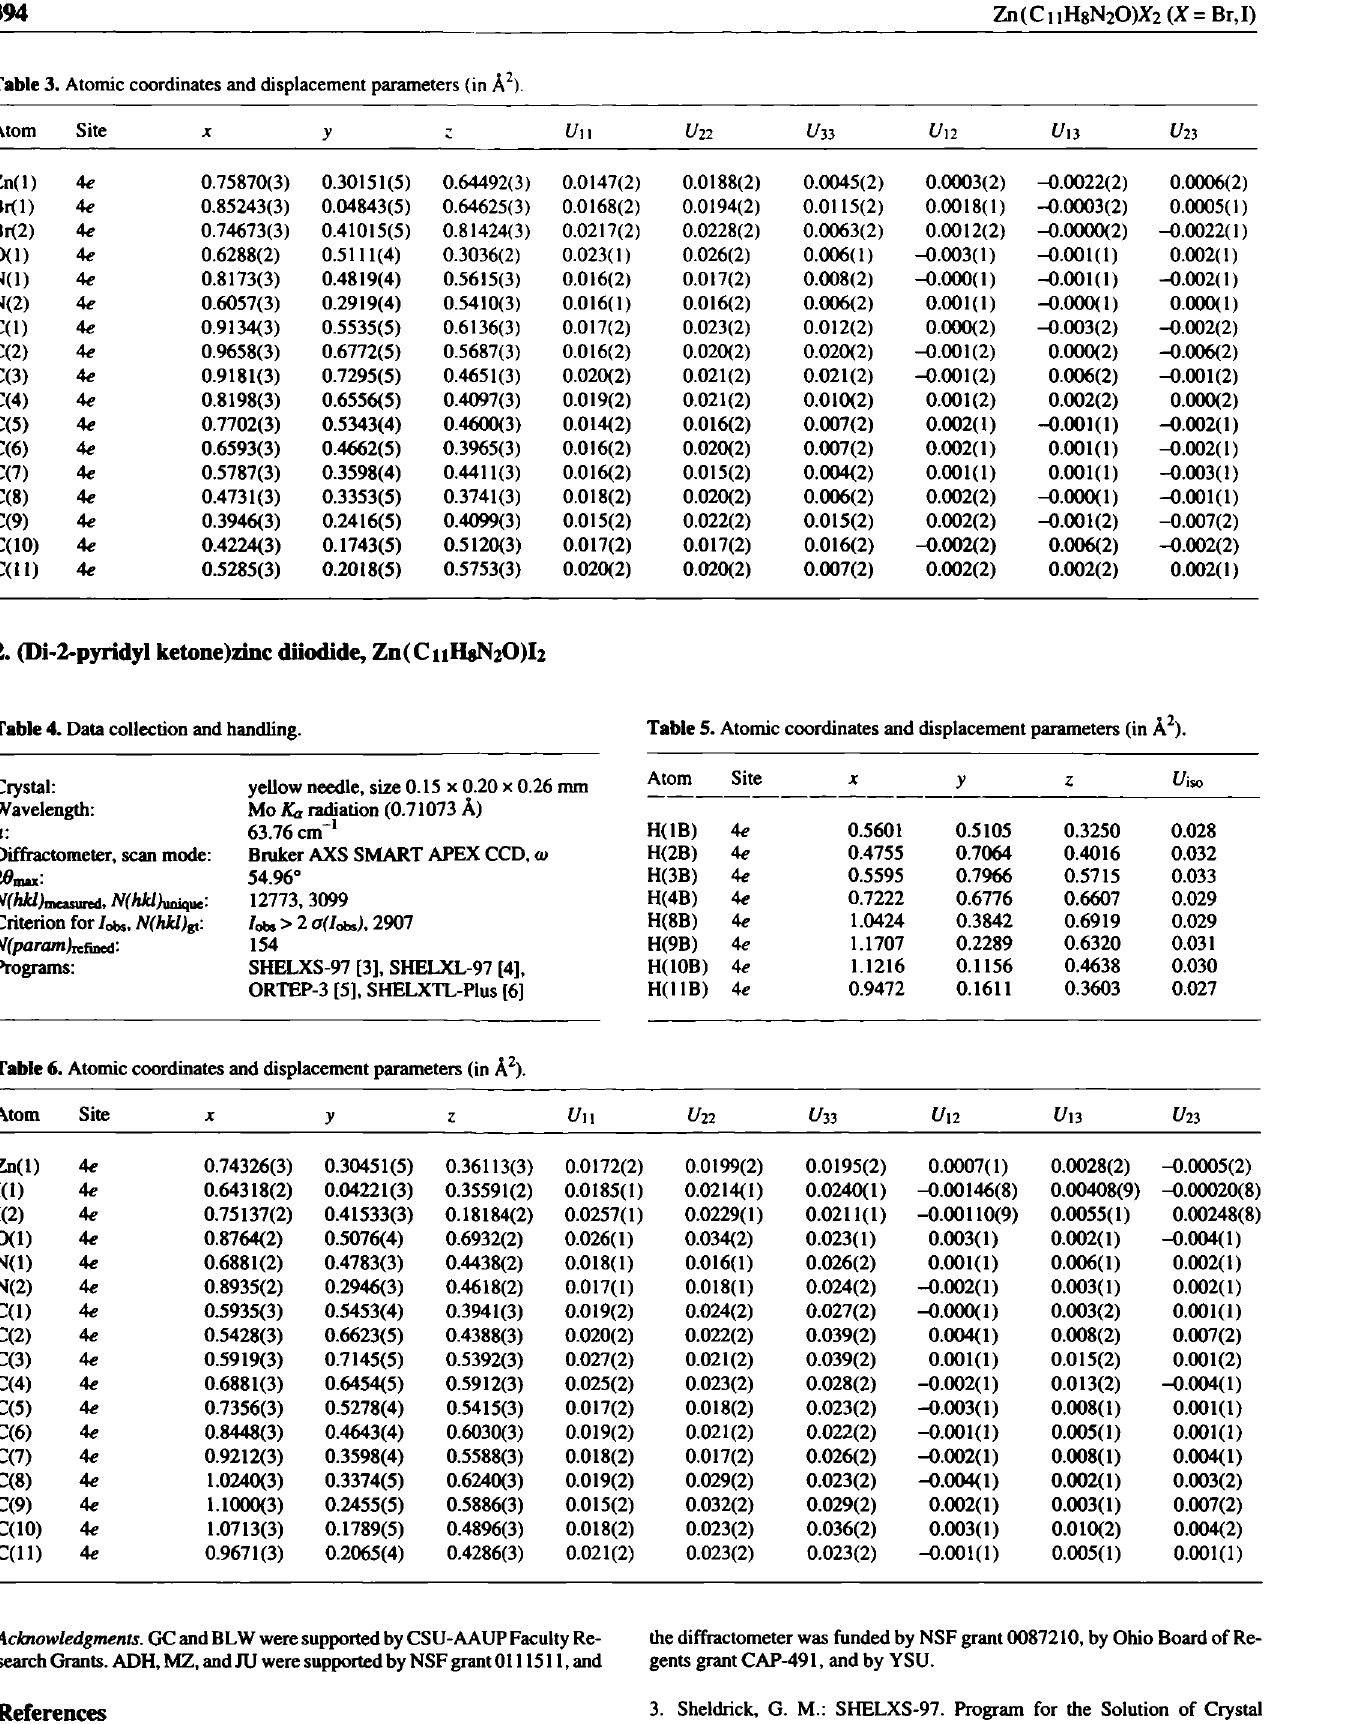
Table 6. Atomic coordinates and displacement parameters (in À 2